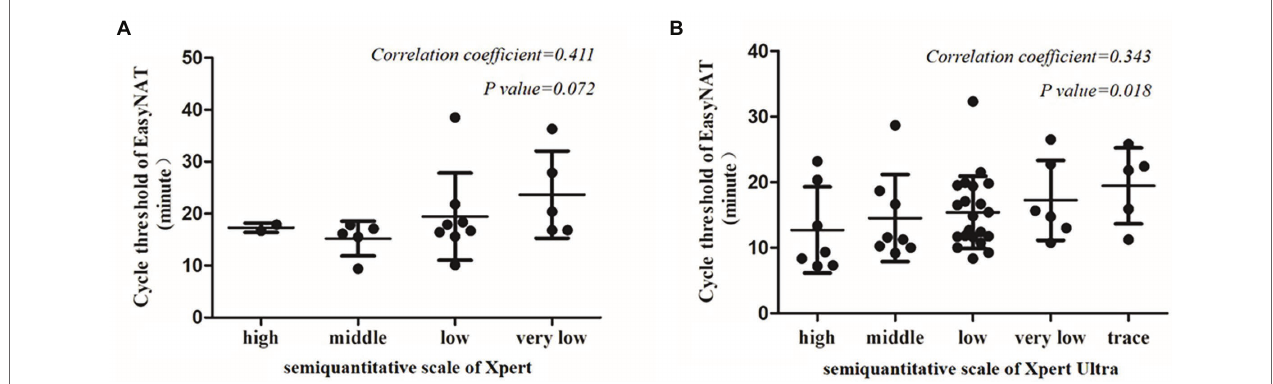
FIGURE 3 | Correlation between the cycle threshold of EasyNAT MTC assay and the semiquantitative scale of Xpert MTB/RIF or Xpert MTB/RIF Ultra. (A) Correlation between EasyNAT MTC and Xpert MTB/RIF. (B) Correlation between EasyNAT MTC and Xpert MTB/RIF Ultra.